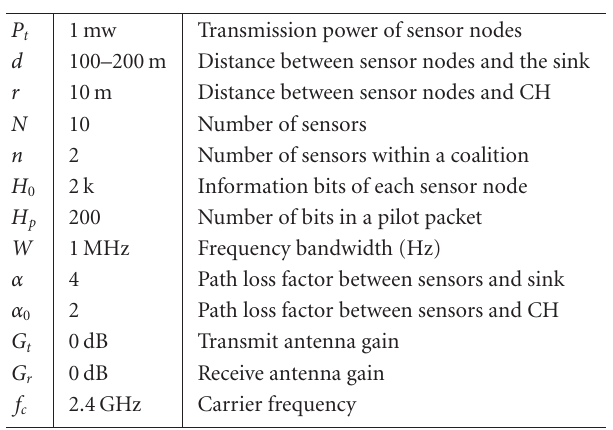
Table 1: Numerical parameters.